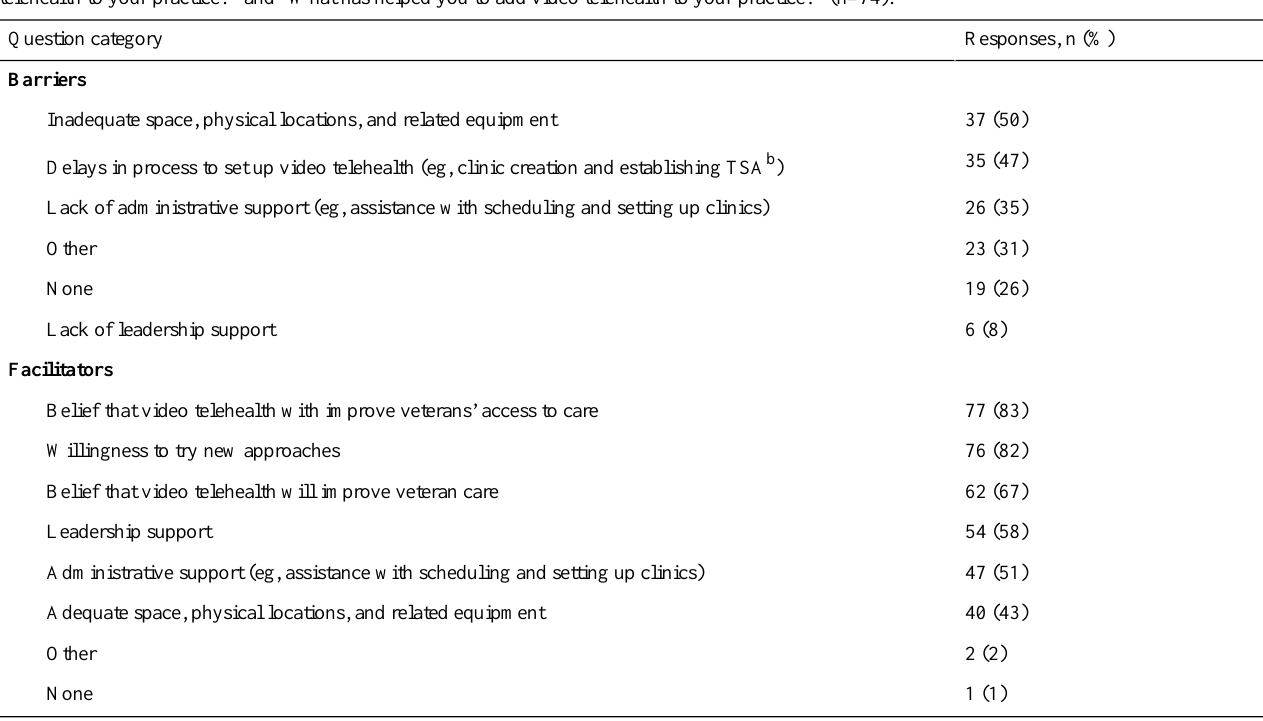
Table 2. Responses from occupational therapists using video telehealth to the questions “What, if any, barriers have you encountered in adding video telehealth to your practice?” and “What has helped you to add video telehealth to your practice?” (n=74). a Barriers